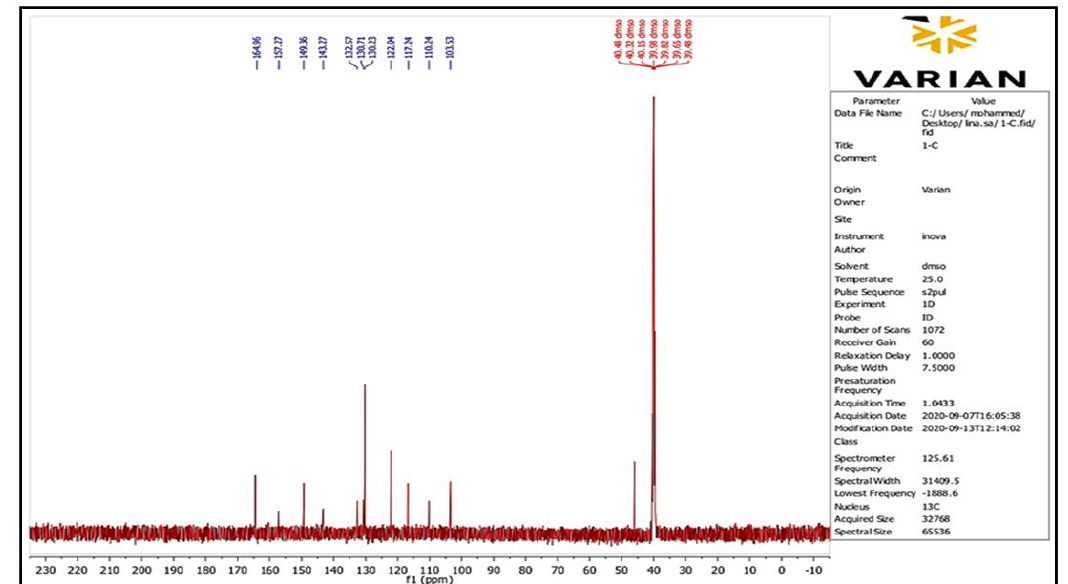
Fig. 4. 13 C NMR spectra of